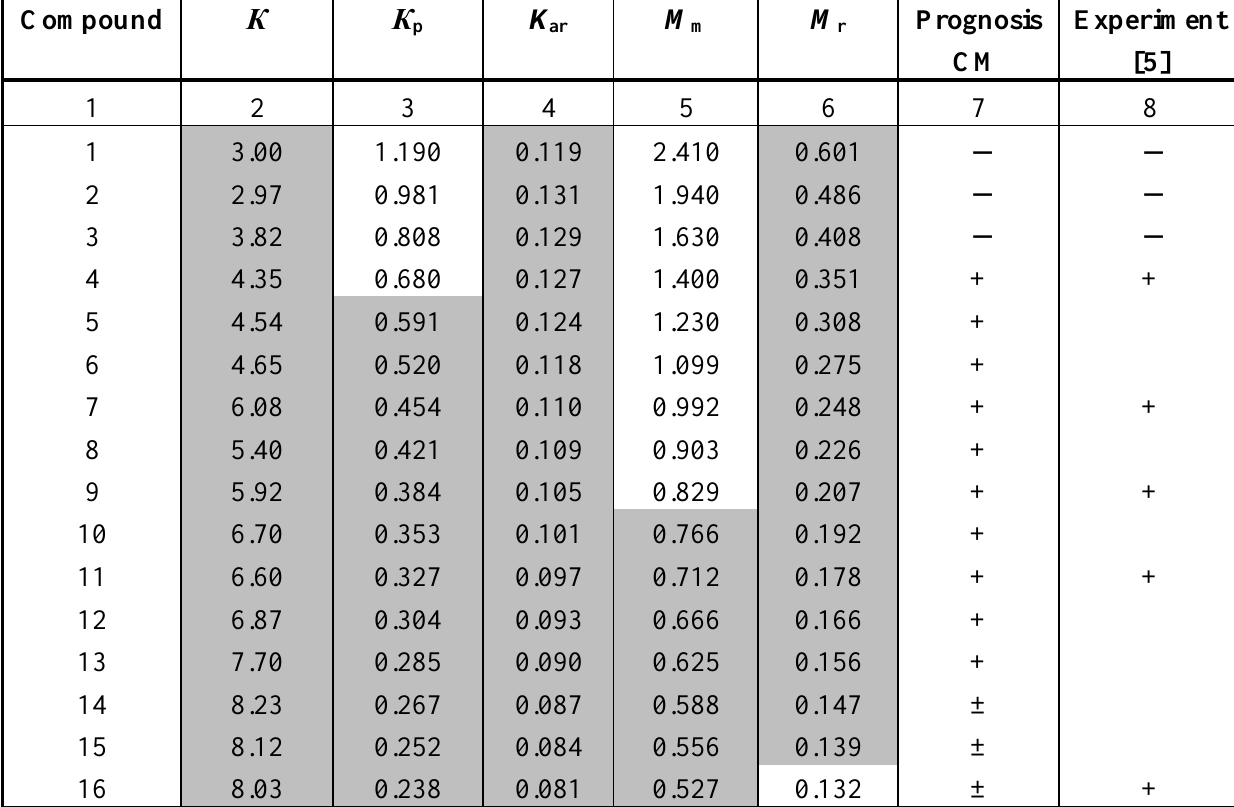
Table 2. Calculated values of molecular parameters of hypothetical and known structures I in view